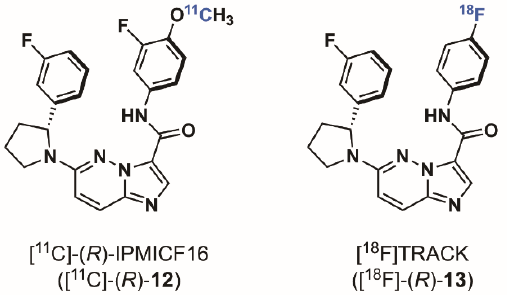
Figure 6. Chemical structures of clinical imidazo[1,2 b ]pyridazine-based Trk-targeted PET radioligands.